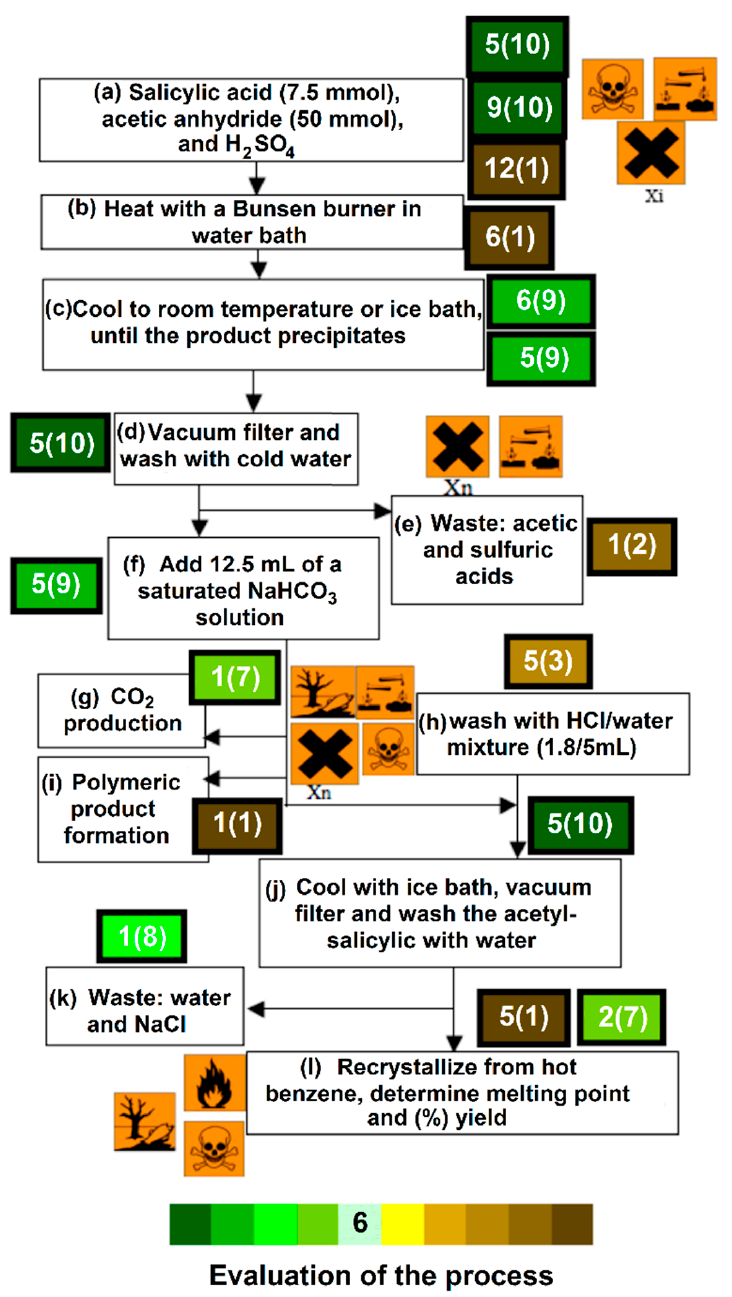
Figure 14. Example of flowchart of the experimental procedure using the Color-Likert scale for evaluation of green chemistry principles. Adapted from Ref. [21].